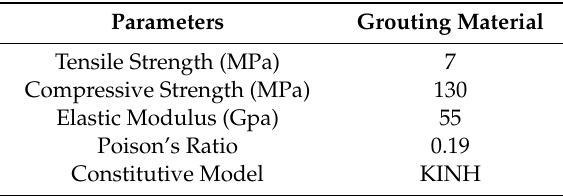
Table 1. Parameters of the grouting material.